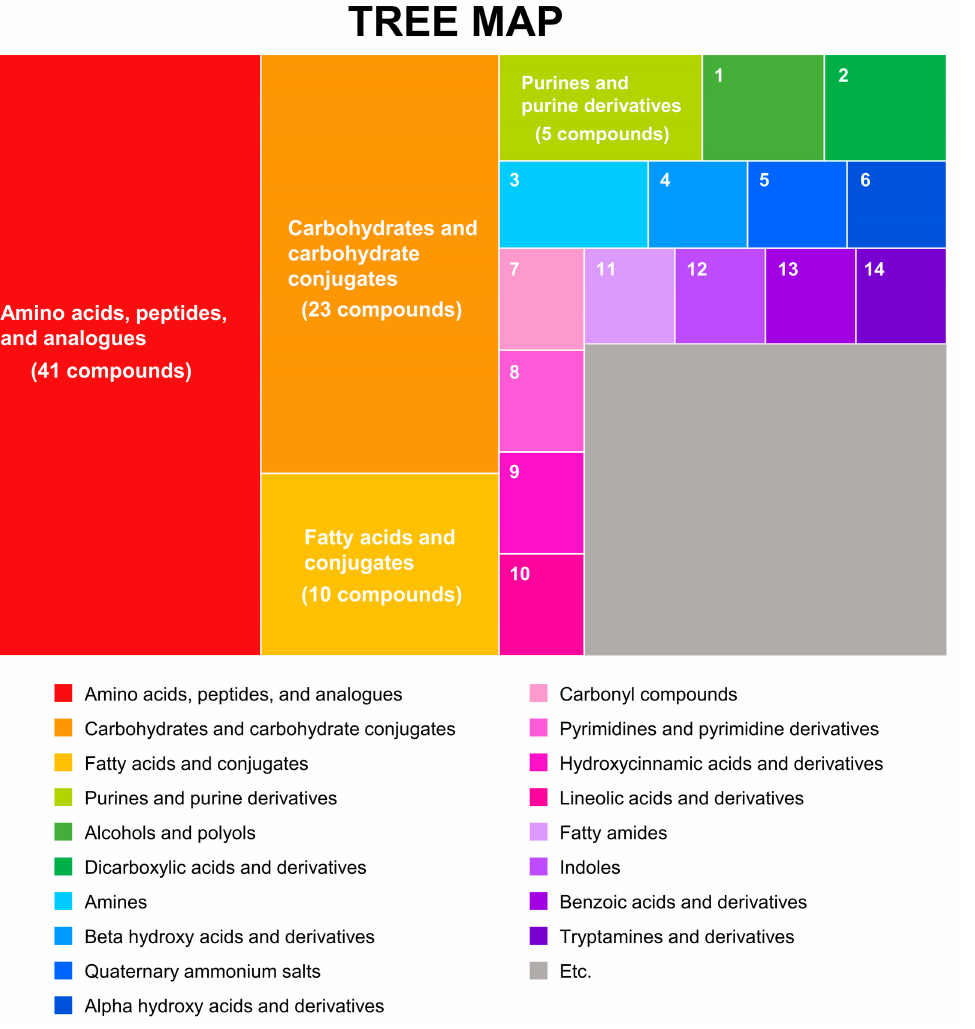
Figure 1. Chemical classification of rice metabolic profiles based on chemical taxonomy. The classification was conducted by chemical taxonomy from Human Metabolome Database (HMDB) (http://www.hmdb.ca) (accessed on 11 July